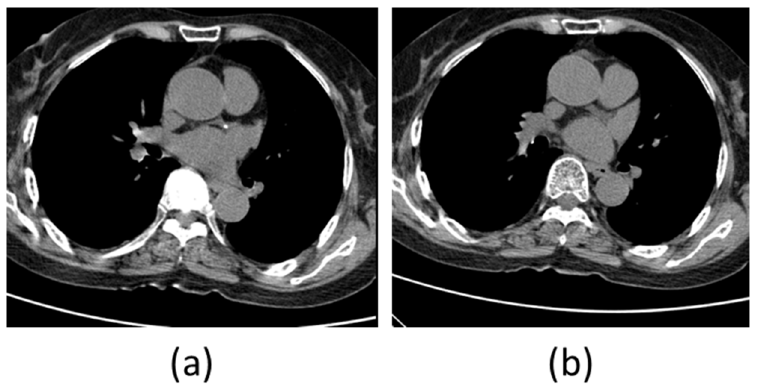
Figure A1. ( a ) CT image with calcification in the artery; ( b ) CT image without calcification.